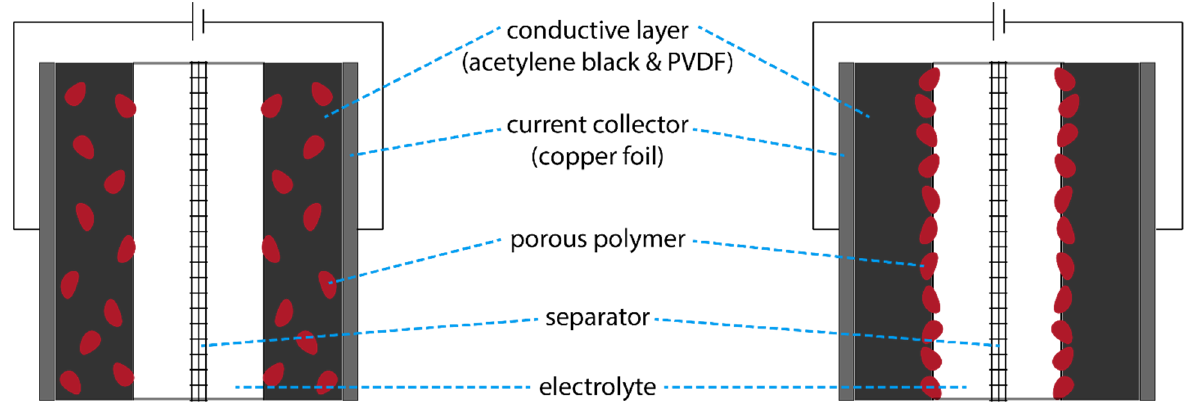
Figure 1. Schematic representation of SCs comprised of two identical electrodes prepared via the conventional mixing method ( left ) or the layer-by-layer method ( right ).